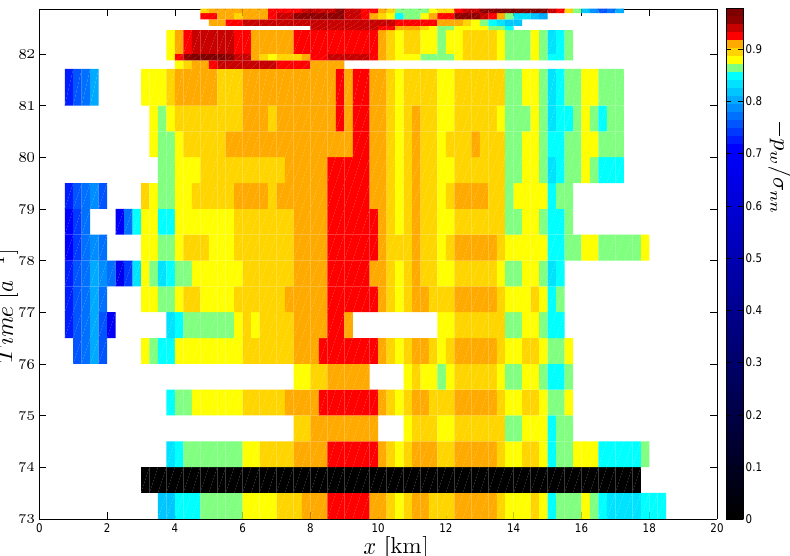
Fig. 6. Evolution with time since 1973 (vertical axis) and position along the central flow line (horizontal axis) of the ratio of basal water pressure over basal normal stress − p w /σ nn .